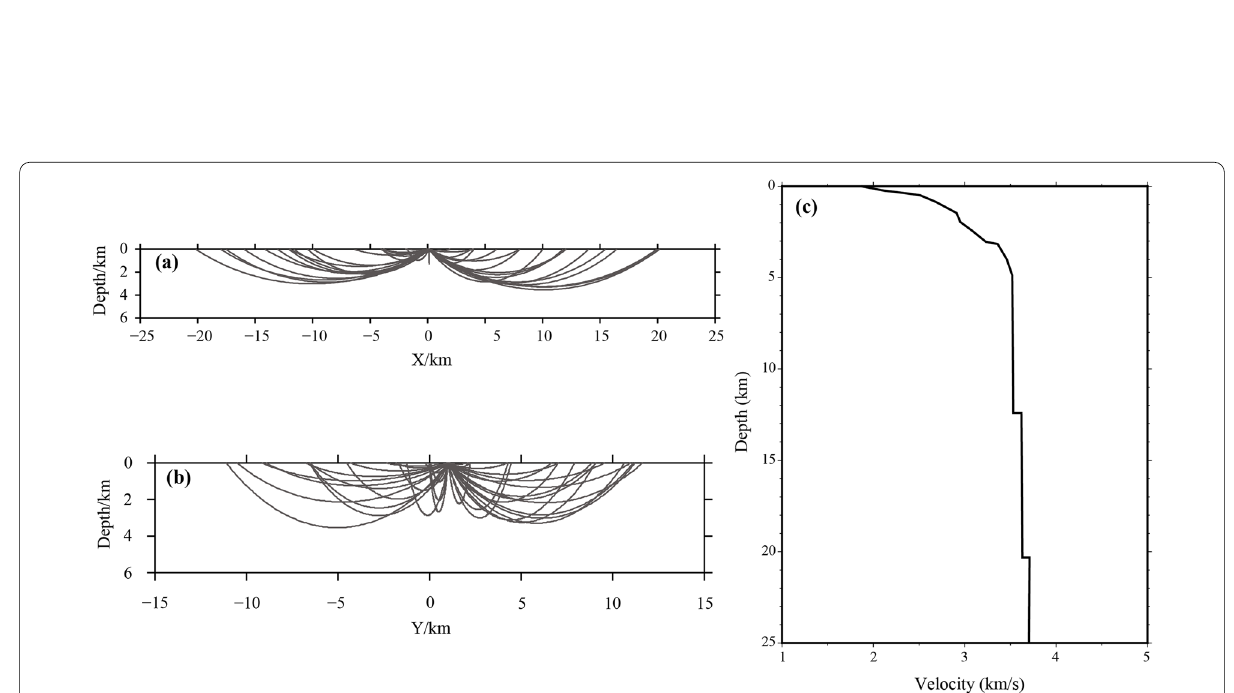
Fig. 4 The ray path and the 1-D velocity model. X in a represents the east–west direction, and Y in b indicates the north–south direction. c is the 1-D S-wave velocity model in the Binchuan area proposed by Chen et al.